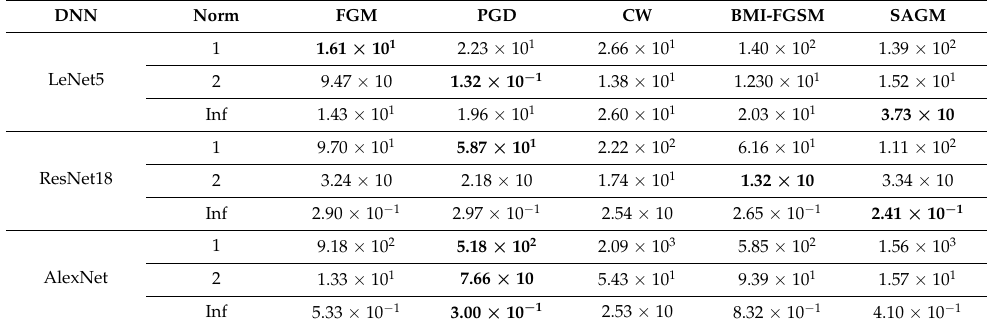
Table 3. Robustness of